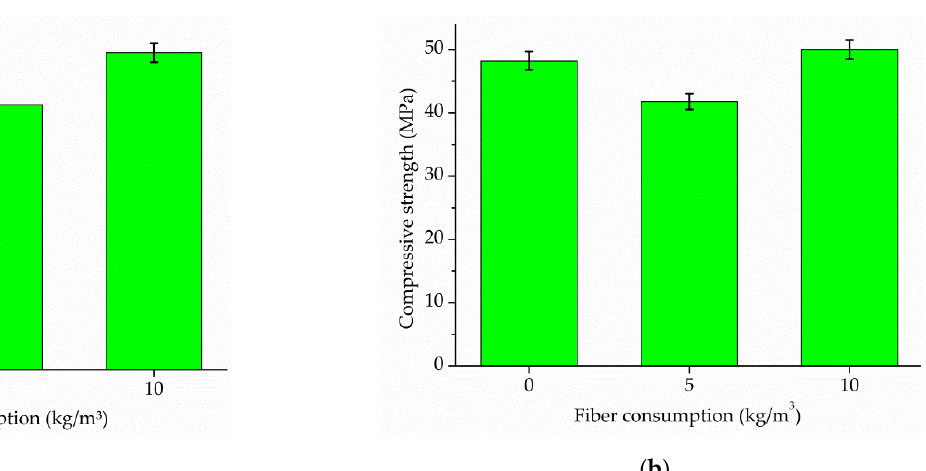
Figure 13. Strength of concrete with different fiber content: ( a ) compressive strength and ( b ) prismatic strength.